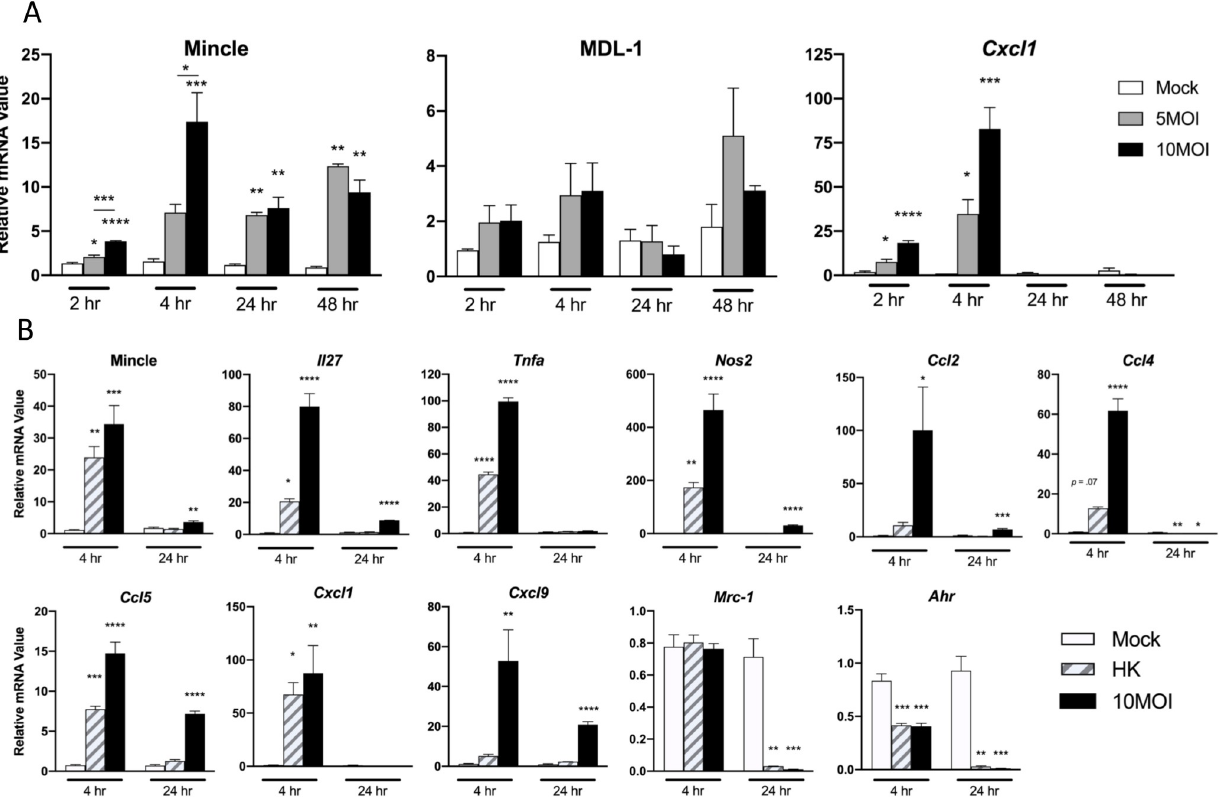
Fig 6. Dose-dependent and sustained activation of Mincle and type-1 markers in M F exposed to O . tsutsugamushi . Bone marrow-derived M F of WT C57BL/6J mice were exposed to live bacteria (MOI 5 or 10) or heat-killed bacteria (HK, MOI 10 equivalent). (A) qRT-PCR analyses of indicated genes at 2 to 48 hr post-infection. (B) qRT-PCR analyses of indicated genes at 4 and 24 hr of incubation with live vs. HK bacteria. Data are presented relative to GAPDH and shown as mean ± SEM. One-way ANOVA with Dunnett’s multiple comparison test was performed, using uninfected controls for each time point as the reference. � , p < 0.05; �� , p < 0.01; ��� , p < 0.001; ���� , p <